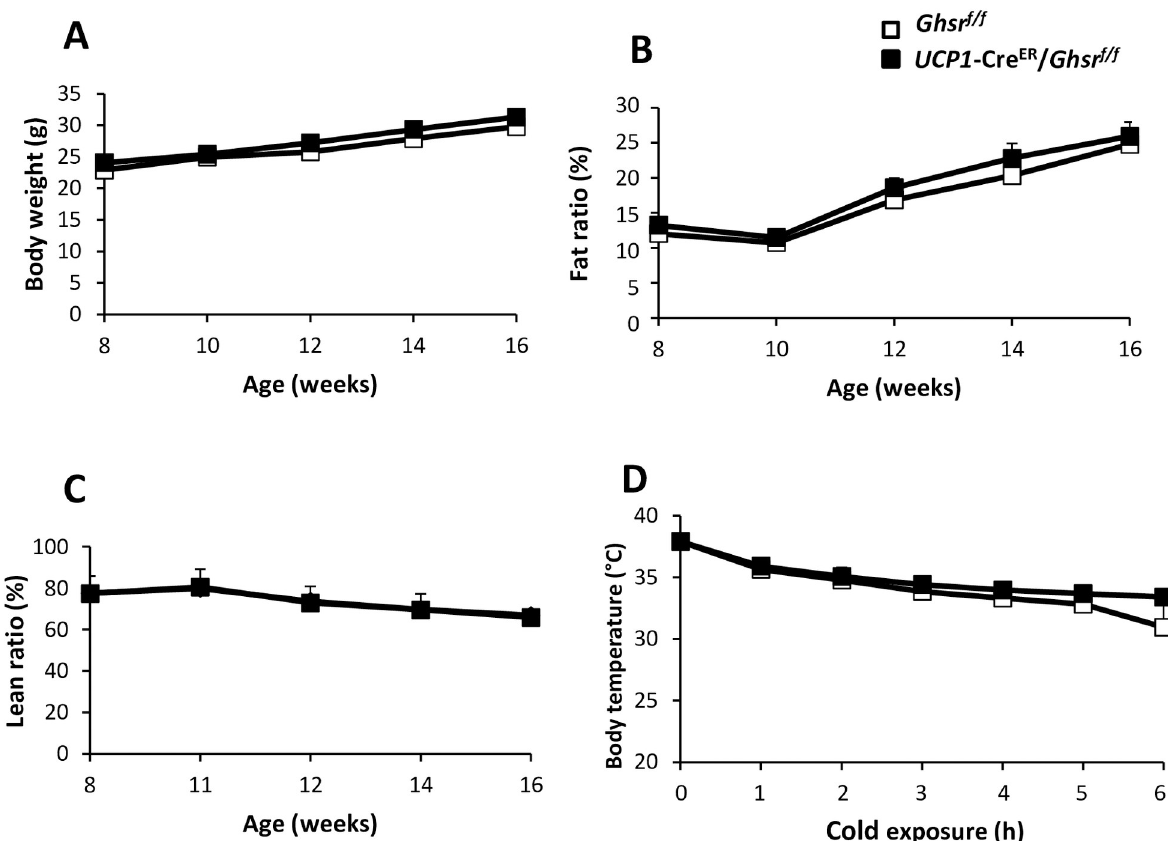
Fig 4. Body weight and body composition of HFD-fed mice. 20-week old male Ghsr f/f and UCP1 -Cre ER / Ghsr f/f mice fed HFD. ( A ) Body weight changes, ( B ) fat percentage, ( C ) lean percentage of Ghsr f/f mice and UCP1 -Cre ER / Ghsr f/f mice. ( D ) Rectal temperature of mice individually caged in 4˚C cold room for 6 h, with free access to food and water. The rectal temperatures were collected every hour. All data were expressed as the mean ± SEM. n = 3–6, � P < 0.05, Ghsr f/f vs . UCP1 -Cre ER / Ghsr f/f